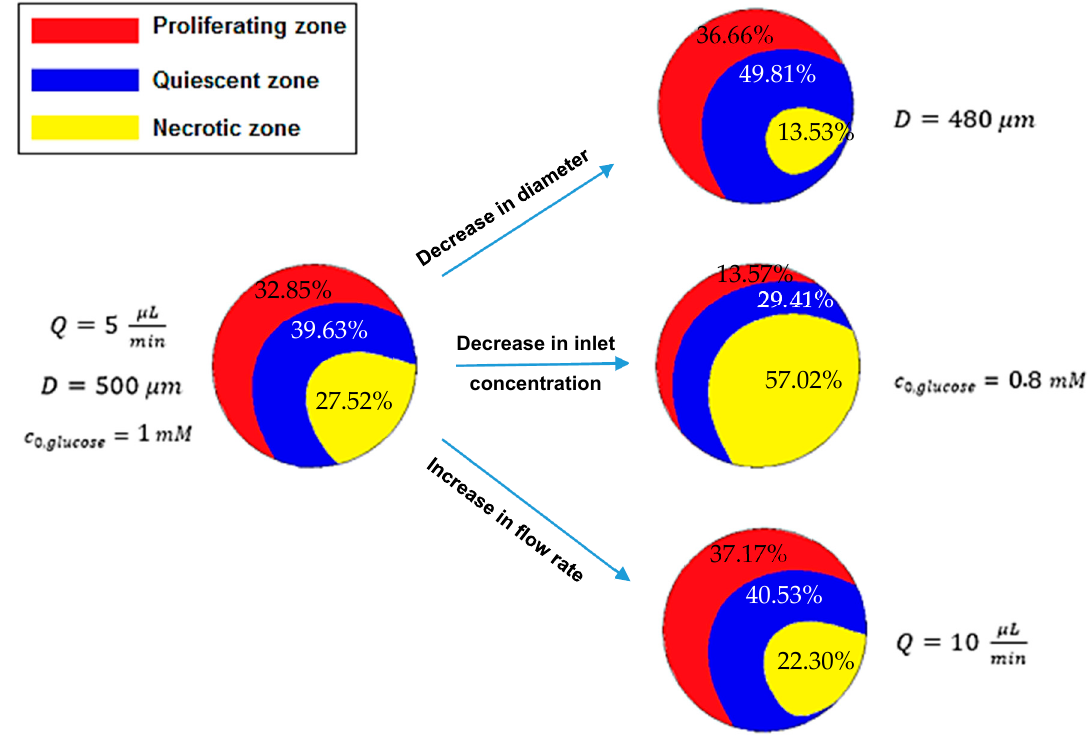
Figure 9. The effects of the diameter D , the inlet concentration of oxygen c 0, glucose and the flow rate Q on the proliferating, quiescent and necrotic zones (red, blue and yellow, respectively) in the middle x – z plane of the spheroid based on glucose concentration distribution. The percentage of each region area to the total area of that cross section is reported on that region.